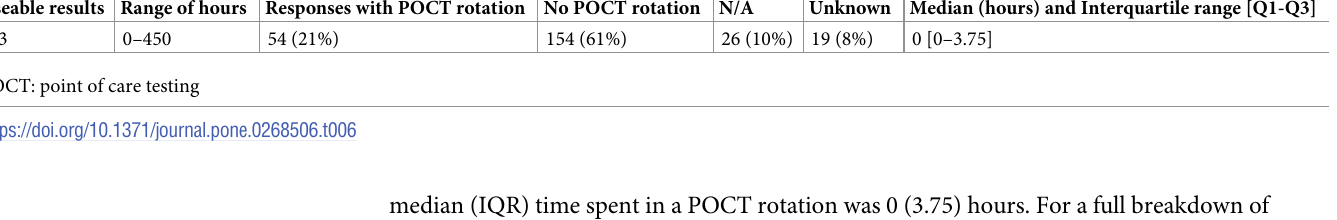
Table 6. Summary of time spent on point of care testing rotation in United Kingdom laboratories. Useable results Range of hours Responses with POCT rotation No POCT rotation